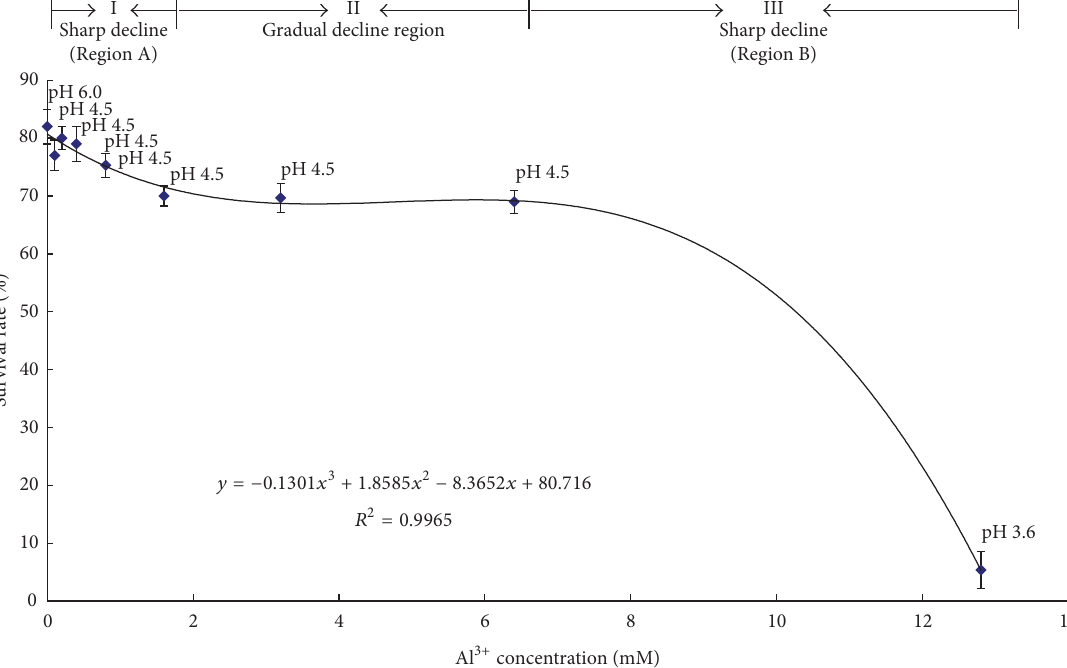
Figure 1: Survival rate of alfalfa under Al stress. The regression equation and the square of correlation coefficient are presented. Based on the regression equation curve, the Al concentration affecting alfalfa germination can be divided into three regions, I of sharp decline (region A); II of gradual decline; III of sudden decline (region